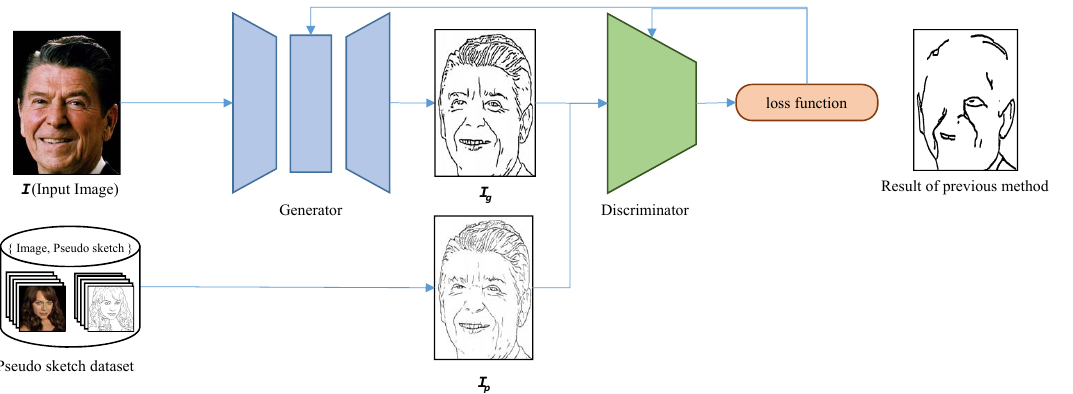
Figure 4. The process of generating line-based sketch images. This initial generator produces a sketch image I 0 g , which shows the quality of the existing work [11]. The initial generator is further trained in the discriminator with the pseudo-sketch image I p from the improved sketch dataset. This generator after training produces a sketch image I g . Note the difference in quality between the produced result I g and the existing result I 0 g